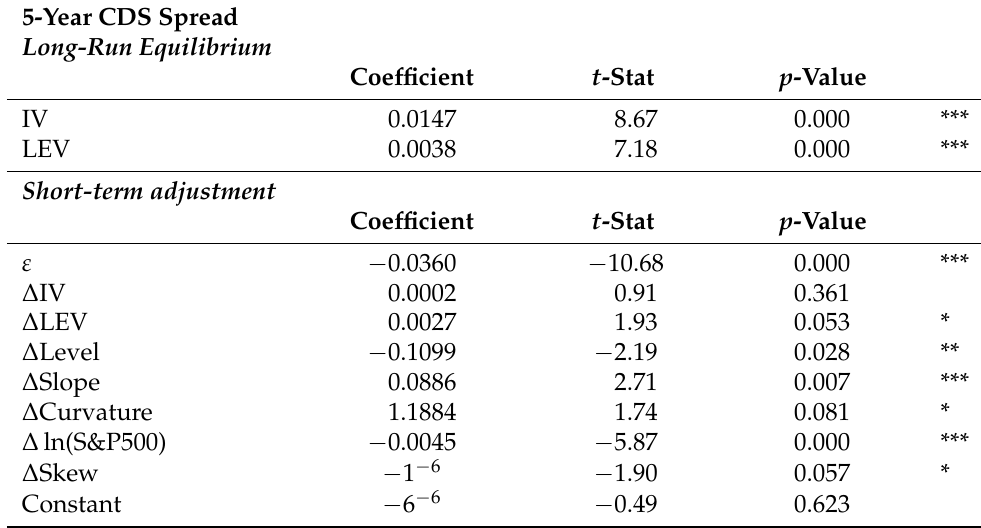
Table 12. ECM for 5-year CDS spreads using the average implied volatility of put options instead of σ S . Similar results are obtained; however, the implied volatility is not significant in the short- term adjustment equation. Additionally, ∆ LEV, ∆ Curvature and ∆ Skew are significant at the 10% significance level only, and ∆ Level is significant at the 5% significance level